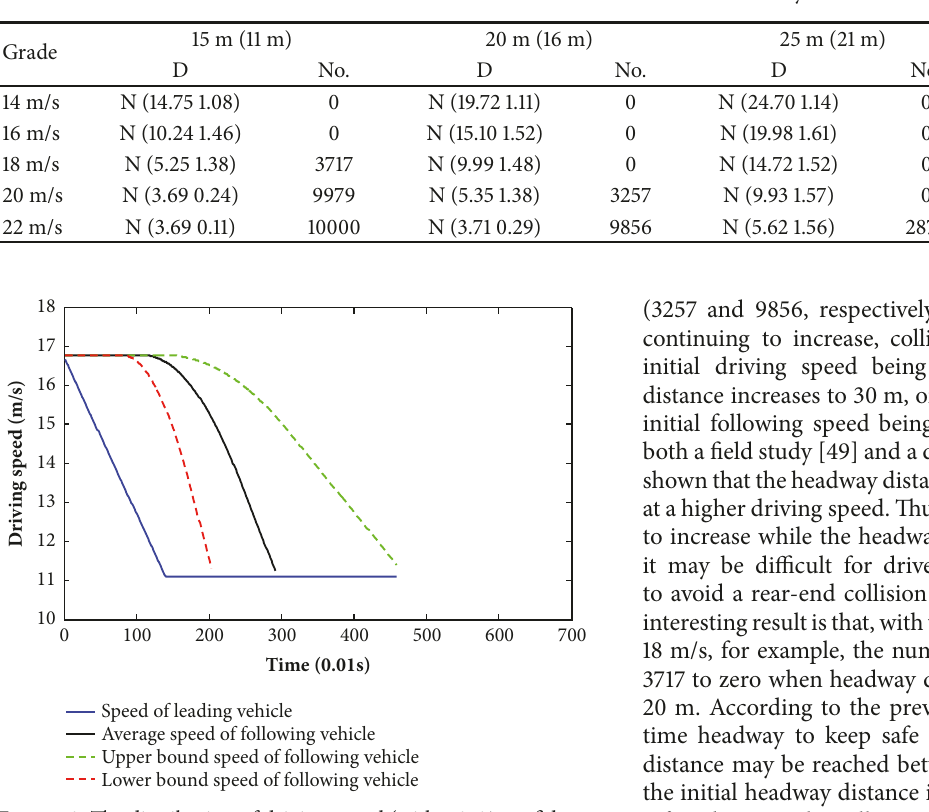
Table 5: The Monte Carlo simulation results under different headway distances and initial speeds.